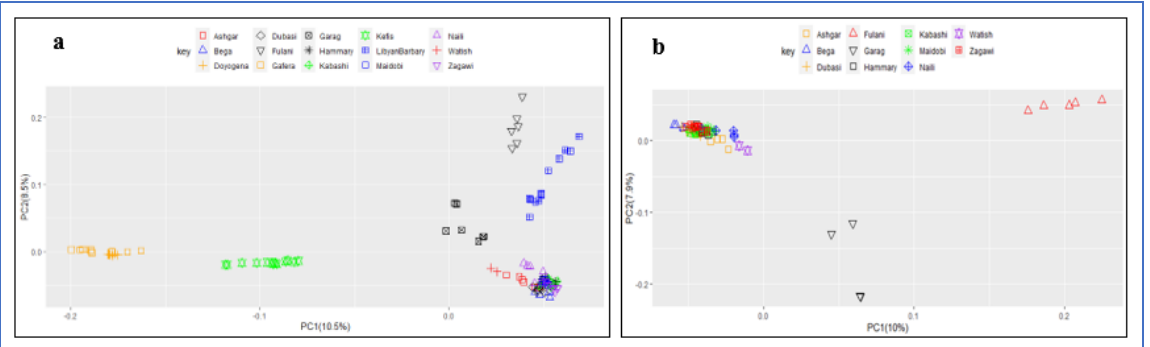
Figure 5. The principal component analysis comprises the sheep populations studied ( a ) in a con- tinental and ( b ) local Sudanese sheep populations dataset context.